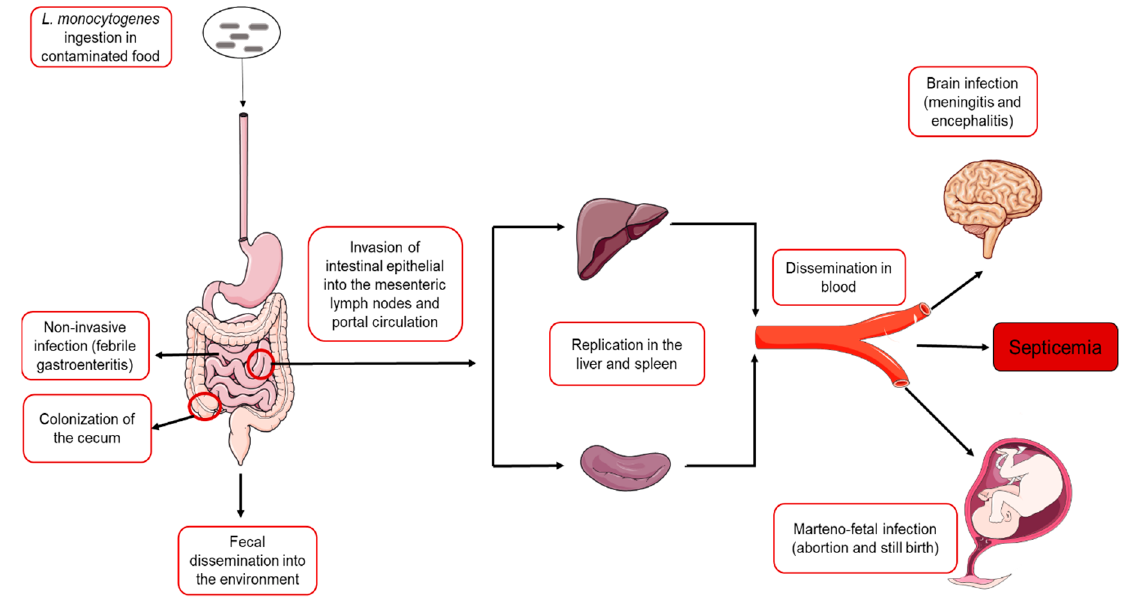
Figure 1. Schematic representation of the infection cycle of L. monocytogenes in humans. Following ingestion of contaminated food, the bacteria invade the intestinal barrier into the bloodstream. Through the portal circulation, the organism is transported to the liver and spleen where it multiplies before being disseminated into the bloodstream. The organism subsequently infects the brain and the placenta/fetus in pregnant women. The schematic art pieces were obtained from Servier Medical art (https://smart.servier.com (accessed on 1 March 2022)). Servier Medical Art by Servier is